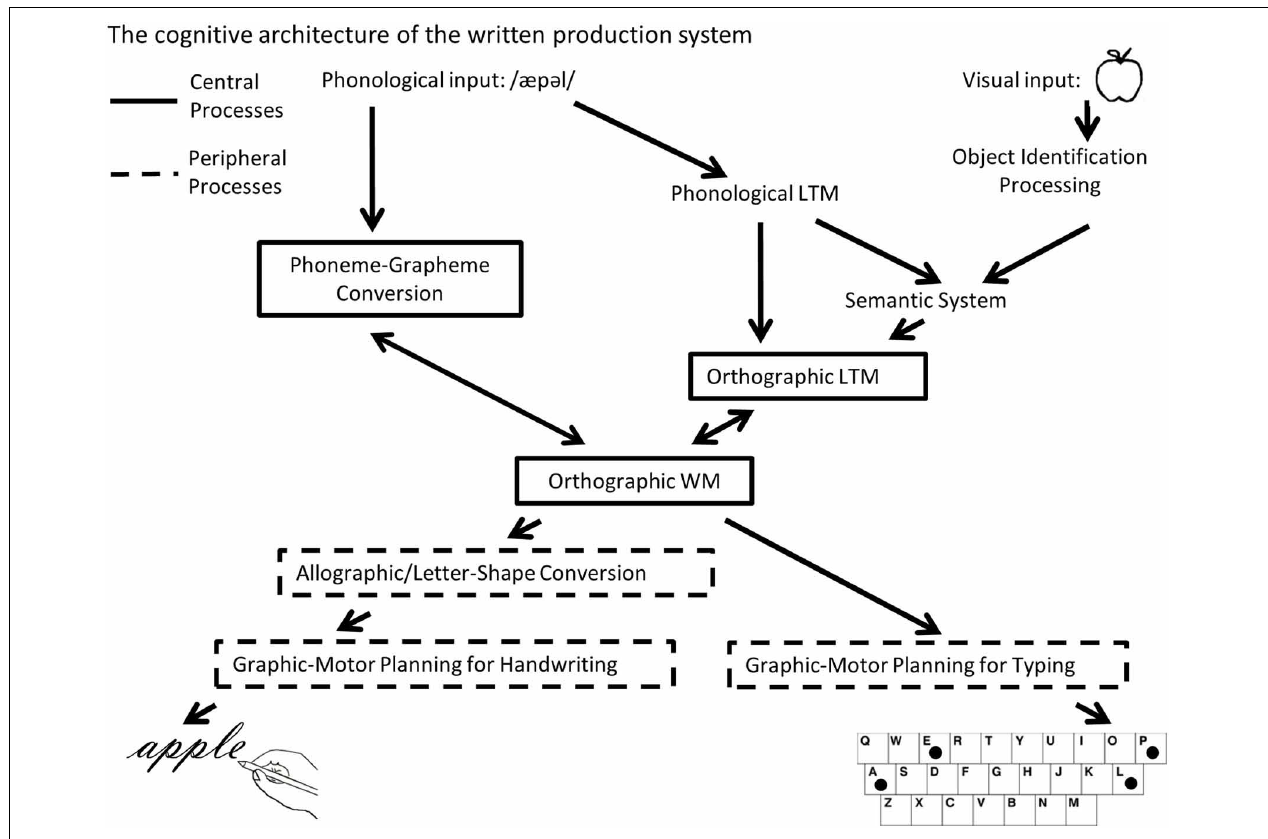
FIGURE 1 | A schematic depiction of the cognitive architecture of the written word production system that distinguishes between central and peripheral spelling processes (adapted from Purcell et al., 2011).